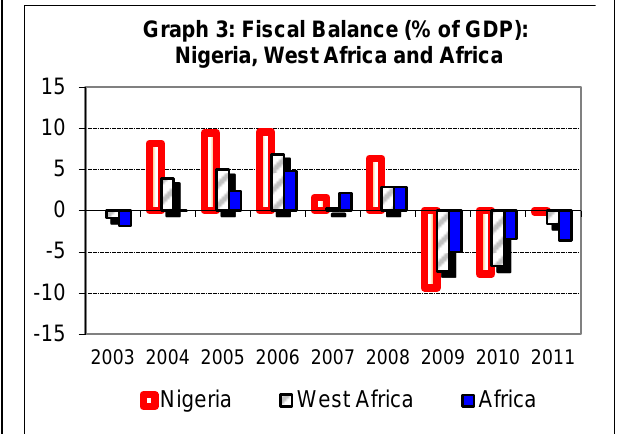
Graph 3: Fiscal Balance (% of GDP):